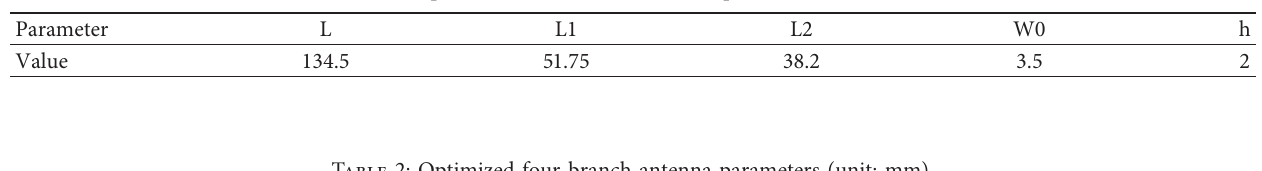
Table 1: Optimized three-branch antenna parameters (unit: mm).